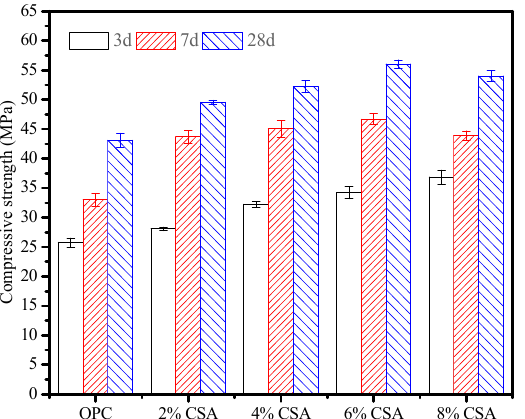
Figure 2. Compressive strength developments in blended cement mortars at different stages.